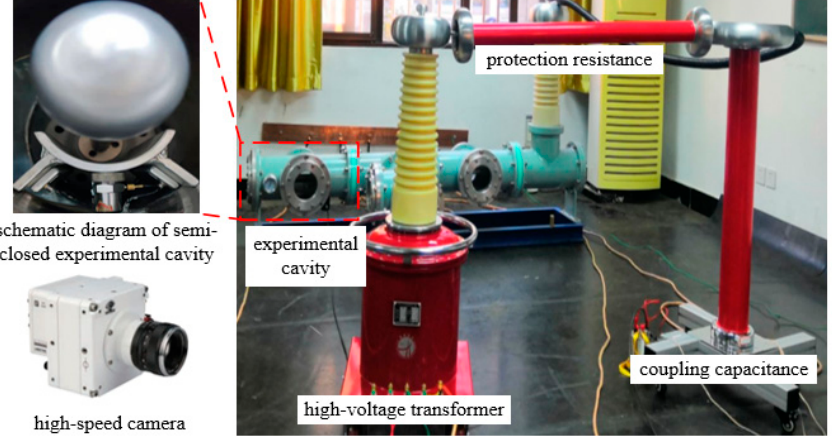
Figure 2. Schematic diagram of the experimental equipment. In order to simulate the four types of metal particle faults in the GIL/GIS equipment: single spherical particle (1.0 mm), single spherical particle (1.5 mm), two spherical particles (1.0 mm) and three spherical particles (1.0 mm) are, respectively, placed at the middle of the bottom of the semi-closed experimental cavity. Figure 3 shows the movement images of spherical particles taken by a high-speed camera.